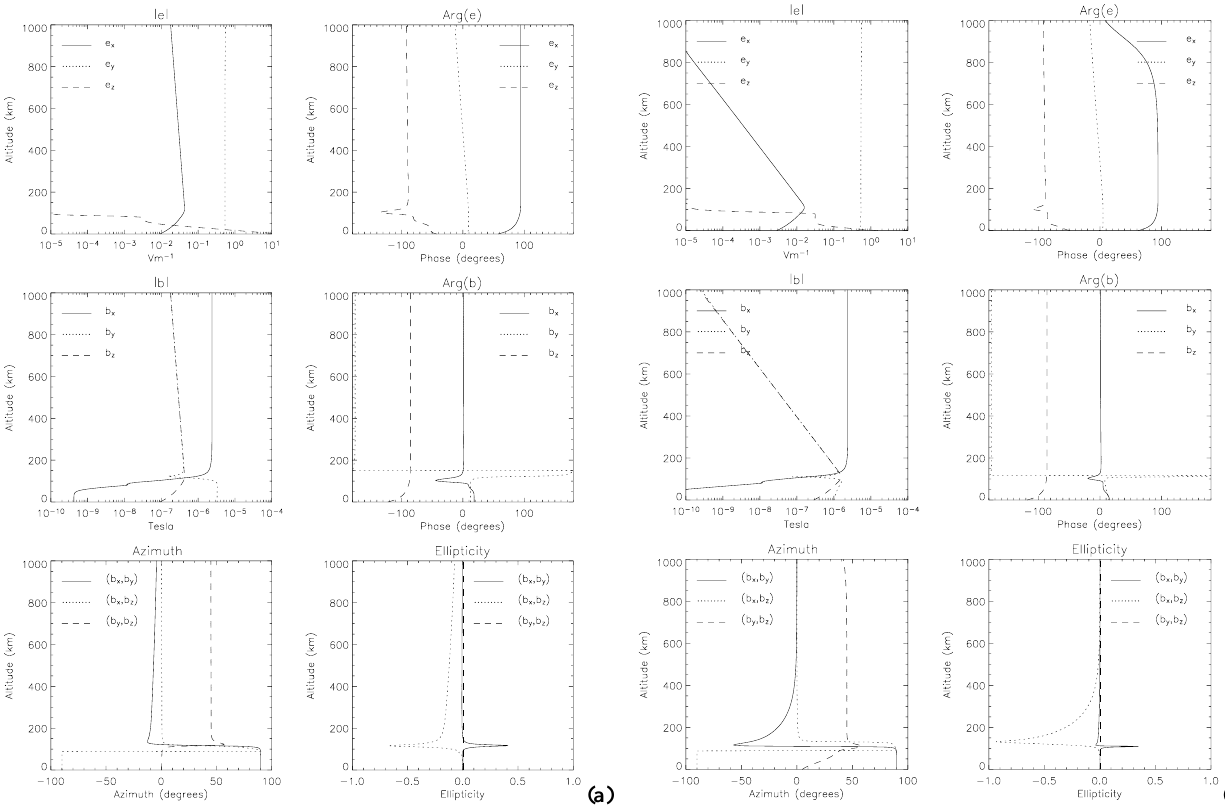
Fig. 3. Polarisation azimuth computed from b x and b y for a vertical B 0 . In (a) k x = 10 − 10 m − 1 and k y = 10 − 6 m − 1 , similar to Fig. 2 while in (b) k x = 10 − 10 m − 1 and k y = 10 − 5 m − 1 for frequency of f = 16mHz at solar minimum with V a = 2 . 8 × 10 6 ms − 1 at 1000km altitude. The wave fields are X (solid), Y (dotted) and Z